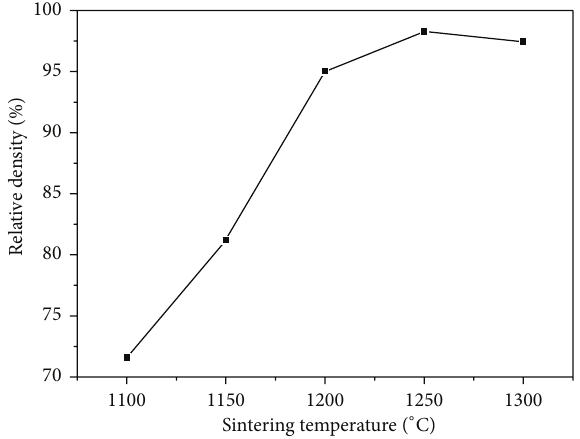
Figure 3: Relative density profile of 60TCP40HA sintered body according to sintering